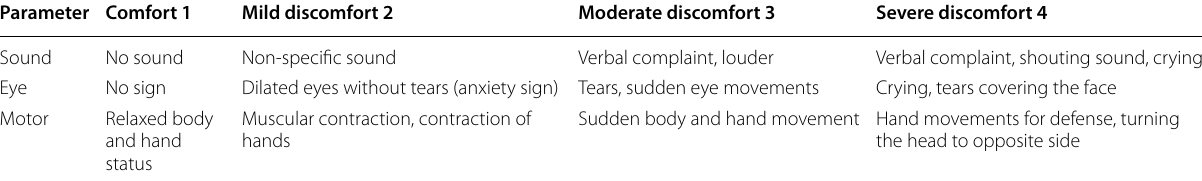
Table 2 Mean, standard deviation (SD), frequencies ( n ), percentages and results of Student’s t test and Chi-square test for comparisons between baseline characteristics in the two groups